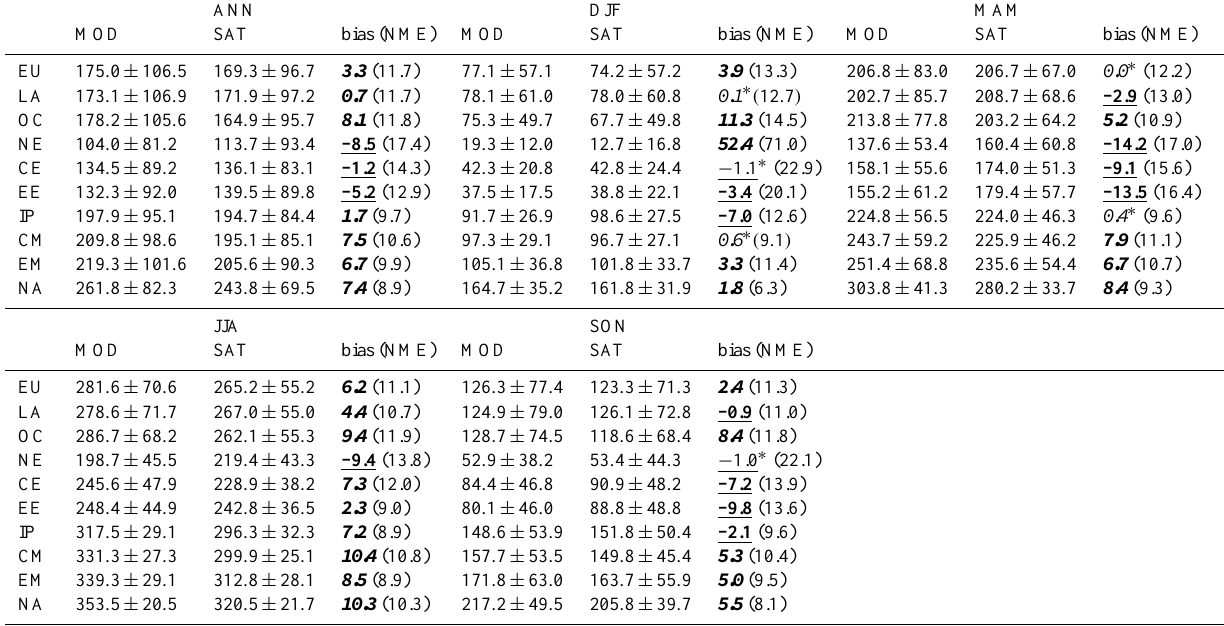
Table 2. Average RegCM4 SSR and CM SAF SSR (MSG SEVIRI) with their standard deviations ( ± 1 σ ) and the corresponding normalized mean bias (NMB) and normalized mean error (NME) per season and region. When the difference between RegCM4 and CM SAF SSR is statistically significant at the 95% confidence level due to a two-independent-sample t test, the NMB values are marked with bold letters, while in the opposite case they are marked with an asterisk. Positive NMBs are italic, while negative NMBs are underlined. ANN denotes annual results and DJF, MAM, JJA and SON the winter, spring, summer and autumn results,